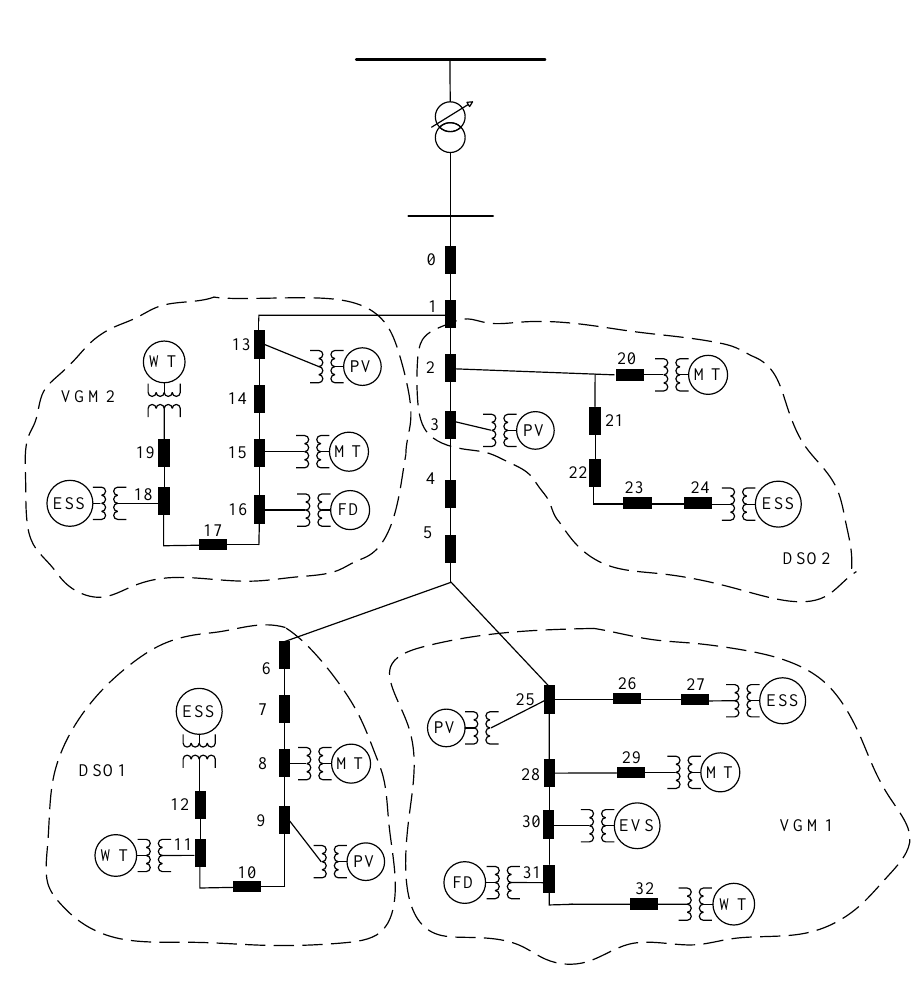
Figure 3. Adjusted active distribution network structure. Table 3. Sources integration of VMG and DSO.